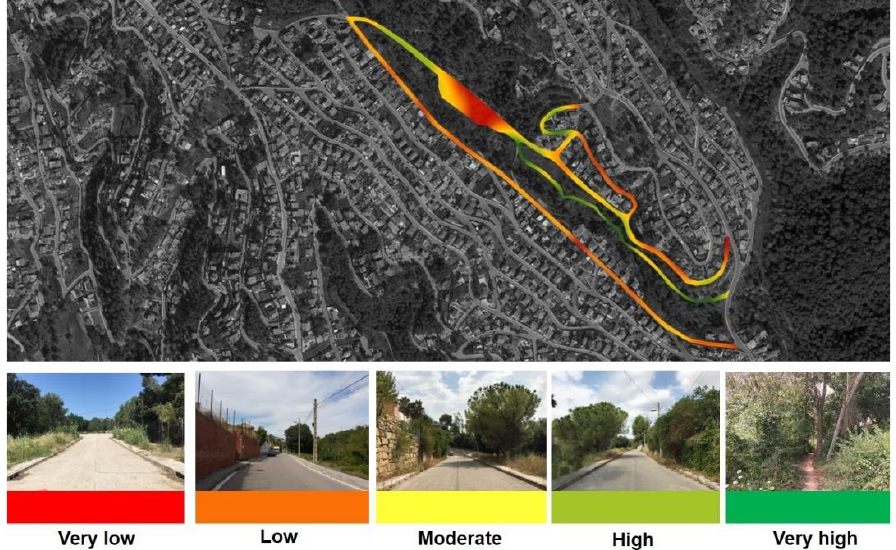
Figure 5. The visual preference mapping generated during the workshop with the locals (colour gradient from least to most preferred areas: red indicates areas of improvement, and green indicates areas with potential).